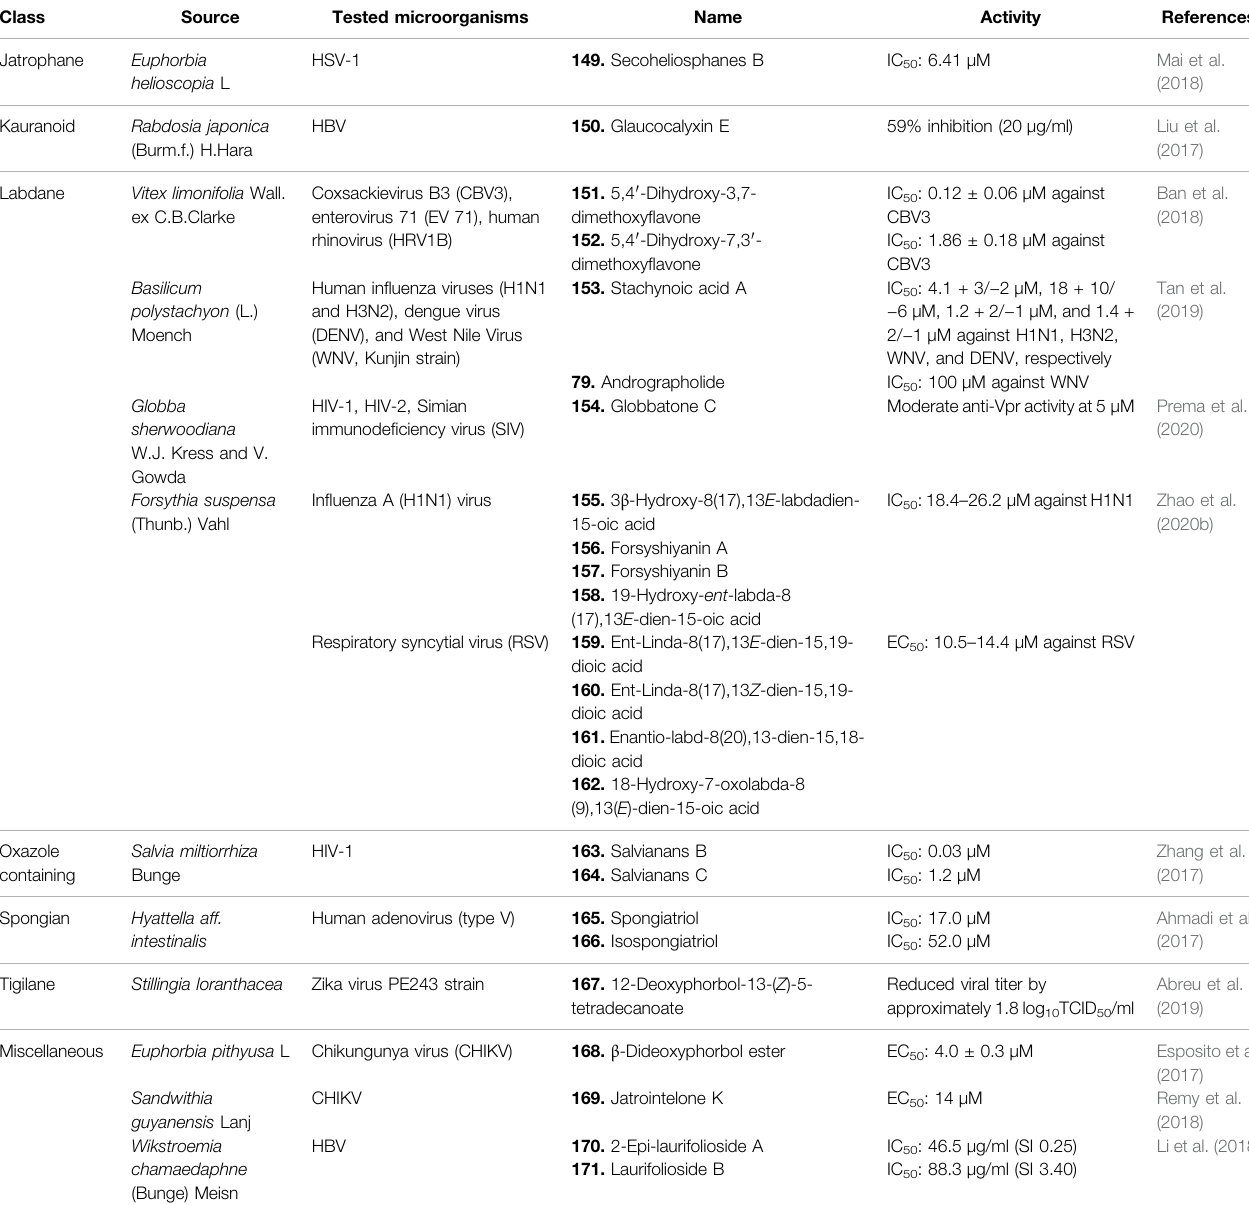
concentration of 100 μ M ( Table 2 ) (Wang B. et al., 2018). eleven known molecules isolated from Euphorbia neriifolia L [Euphorbiaceae], only 109 and 110 showed moderate anti- human immunode fi ciency virus (HIV)-1 activities, with EC 50 values of 34 mM (selectivity index, SI = 2.3) and 24 mM (SI =